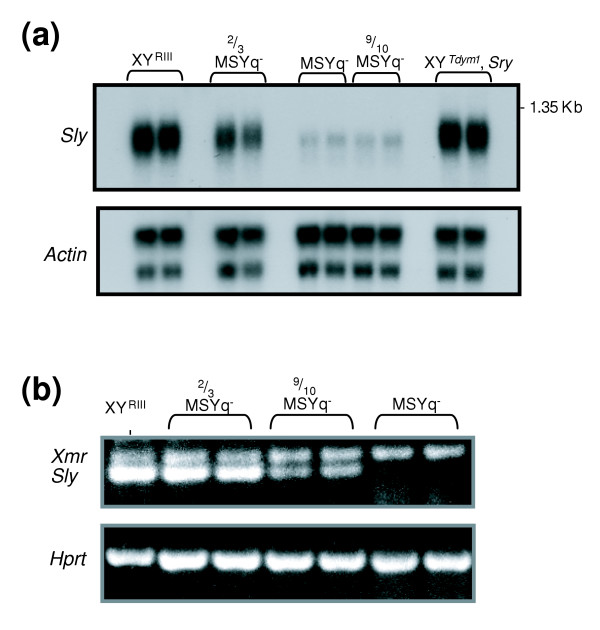
Transcription of Sly is reduced or absent in the MSYq deficient males. (a) Northern blot of total testis RNA probed with the microarrayed Sly cDNA clone MTnH-K10 and with an actin probe as a loading control. Hybridization to the Sly probe is clearly reduced in 2/3MSYq- males and is further markedly reduced in the two models with more severe MSYq deficiency. (b) Reverse transcriptase polymerase chain reaction analysis of testis cDNA with primers that distinguish between Sly and Xmr transcripts and with Hprt primers as an amplification control. Some Sly transcripts are retained in 9/10MSYq- males but they are absent in MSYq- males.